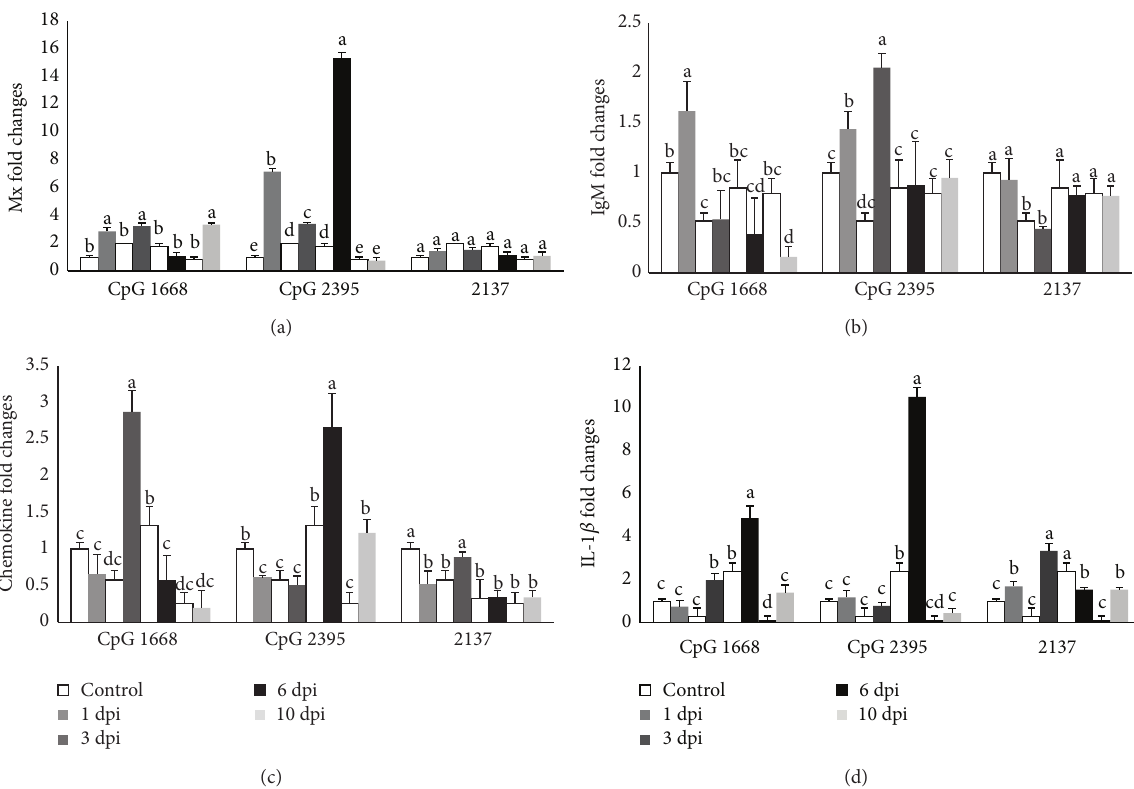
Figure 4: The relative mRNA expressions of Mx (a); IgM (b); CC (c); and interleukin 1- 𝛽 (d) in cobia intestine after stimulating with different CpG ODNs (1668, 2395) and ODN 2137 as control measured by quantitative real-tiePCRat 1, 3, 6, and 10 days after stimulation. The expression values are represented as “fold change” and compared to the noninjected control samples and 𝛽 -actin was used as a reference gene. The results are presented as the mean ± SD ( 𝑛 = 2 ) and mean values with different letters are significantly different ( 𝑃 ≤ 0.05